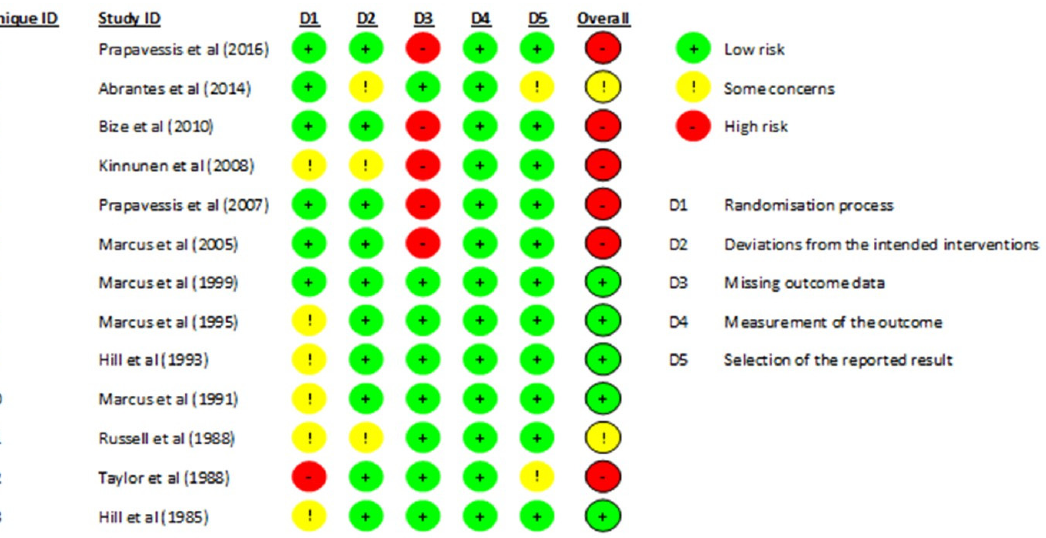
Figure 2. Results of the Cochrane Risk of Bias (CROB2) for the included trials. References cited in the figure are: [37–49].